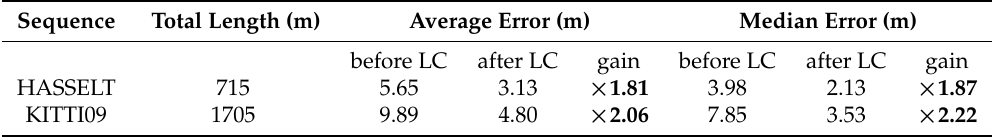
Table 4. The average and median pose error before and after loop closure for the Hasselt and Kitti “09” sequence. Our correction algorithm reduces the error by a factor of approximately × 2 after closing the